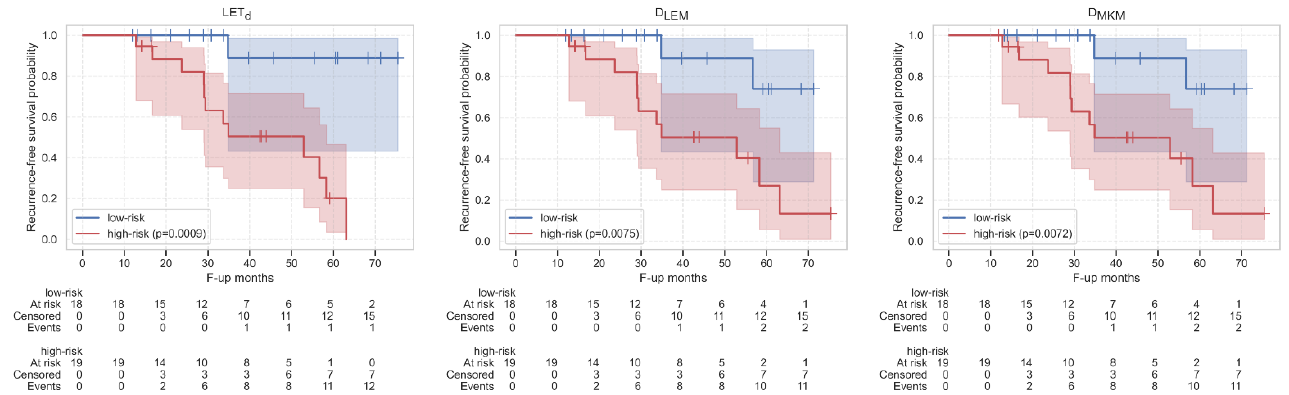
Figure 5. Kaplan–Meier survival curves for patients at high-(red) and low-risk (blue) of HD-LR as stratified by r-Cox using LET d ( left ) D LEM ( middle ), D MKM ( right ) features selected by LASSO. Shaded areas show curves confidence intervals and the p -values obtained from the comparison between high- and low-risk patients are reported in the legend. Censored events are highlighted with the symbol ‘+’. Below the plot, the number of patients belonging to each risk group at specific time points (months) is reported.